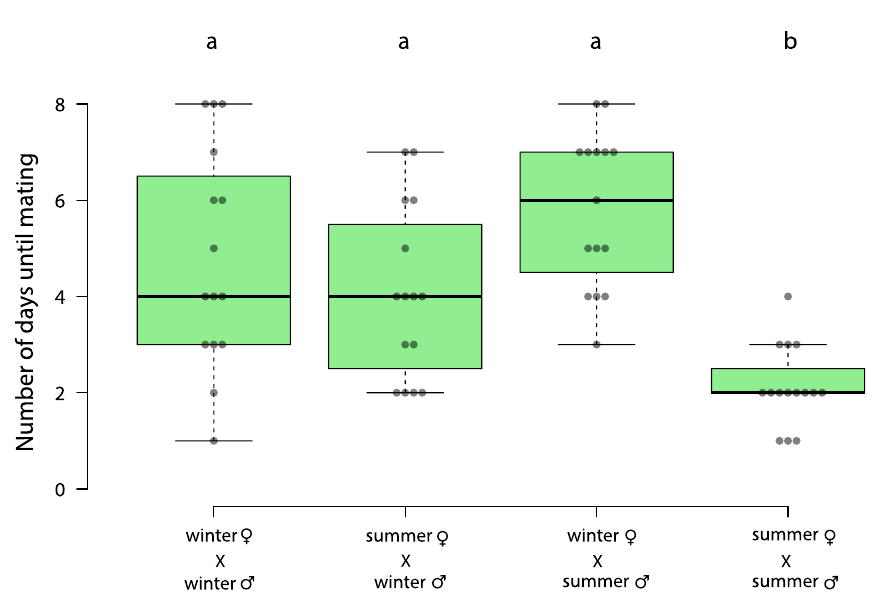
Figure 3. Box plot representing days until the mating event for D. suzukii . Center lines show the medians; box limits indicate the 25th and 75th percentiles, whiskers extend 1.5 times the interquartile range from the 25th and 75th percentiles, n = 15 mating pairs per treatment. All data were analyzed by the Kruskal–Wallis test (H = 25.7; p < 0.0001 with post hoc analysis (Dunn’s test); different letters indicate significant differences ( p <